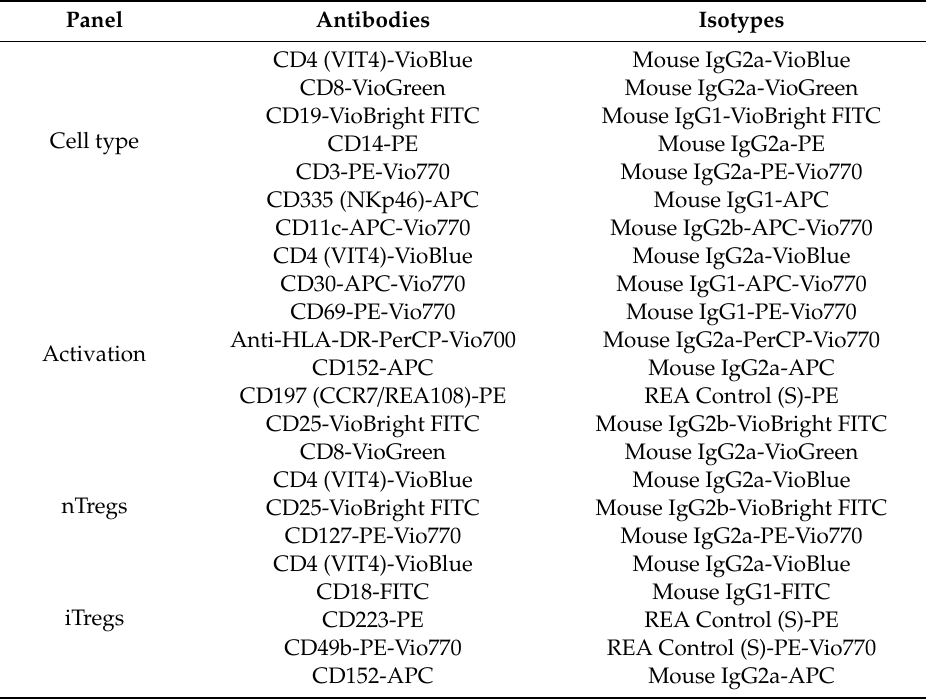
Table 1. Flow cytometry panel with antibodies and corresponding isotypes